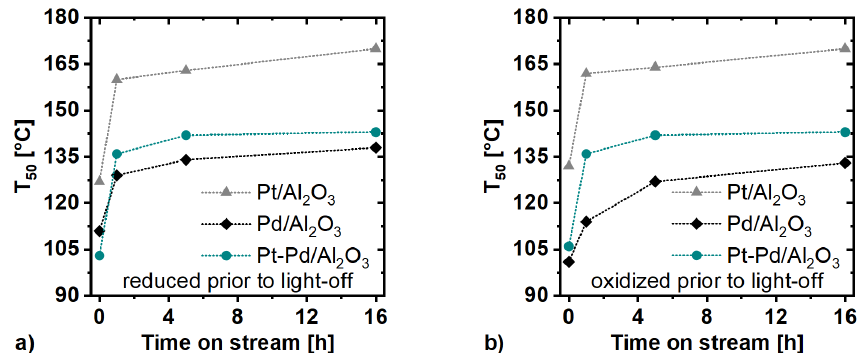
Figure A2. Catalytic activity for CO conversion after oxidative pretreatment of Pt/Al 2 O 3 ( a ), Pd/Al 2 O 3 ( b ), and Pt-Pd/Al 2 O 3 ( c ) during a light-off test in 800 ppm CO, 7% CO 2 , 5% O 2 , 5% H 2 O, and bal. N 2 at a GHSV of 80 000 h − 1 .